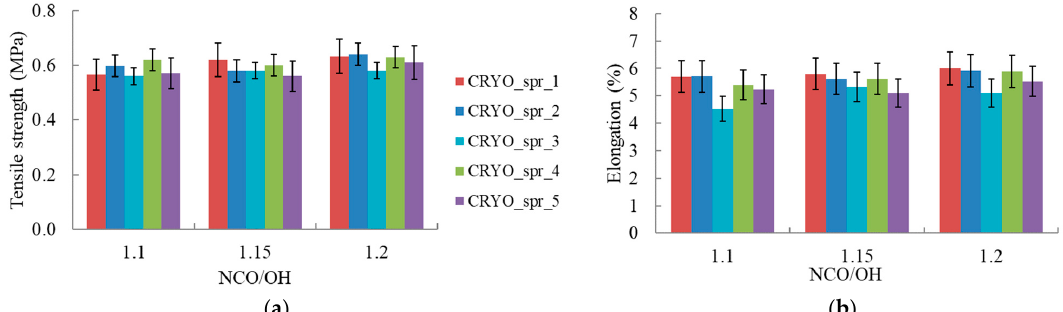
Figure 4. PUR foam tensile properties at 77 K vs. NCO/OH ratio: ( a ) tensile strength; ( b ) elongation at break.